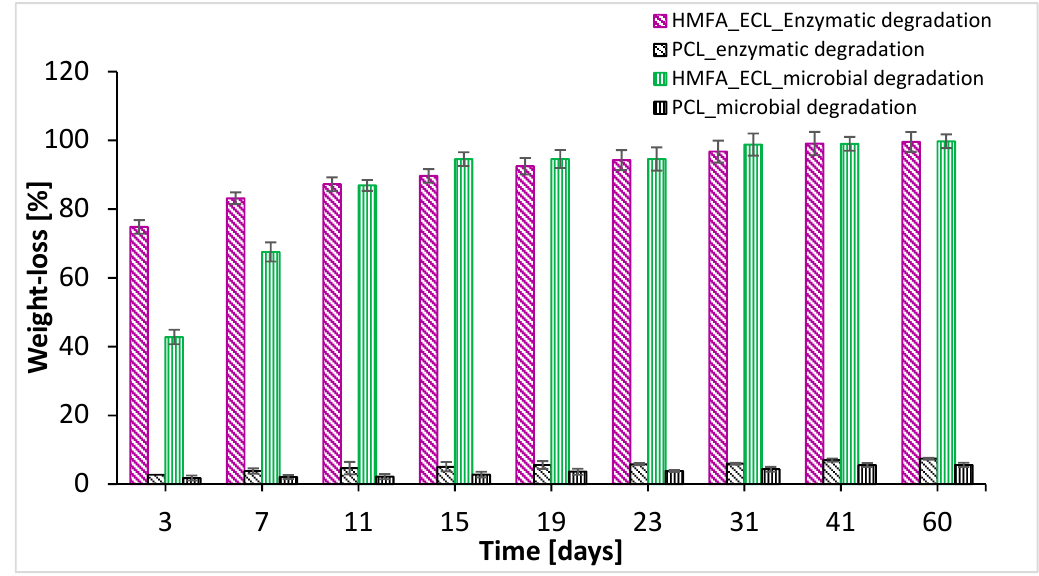
Figure 7. Weight losses of HMFA_ECL and PCL oligoesters after enzymatic (lipase) and microbial degradation, throughout 60 days.